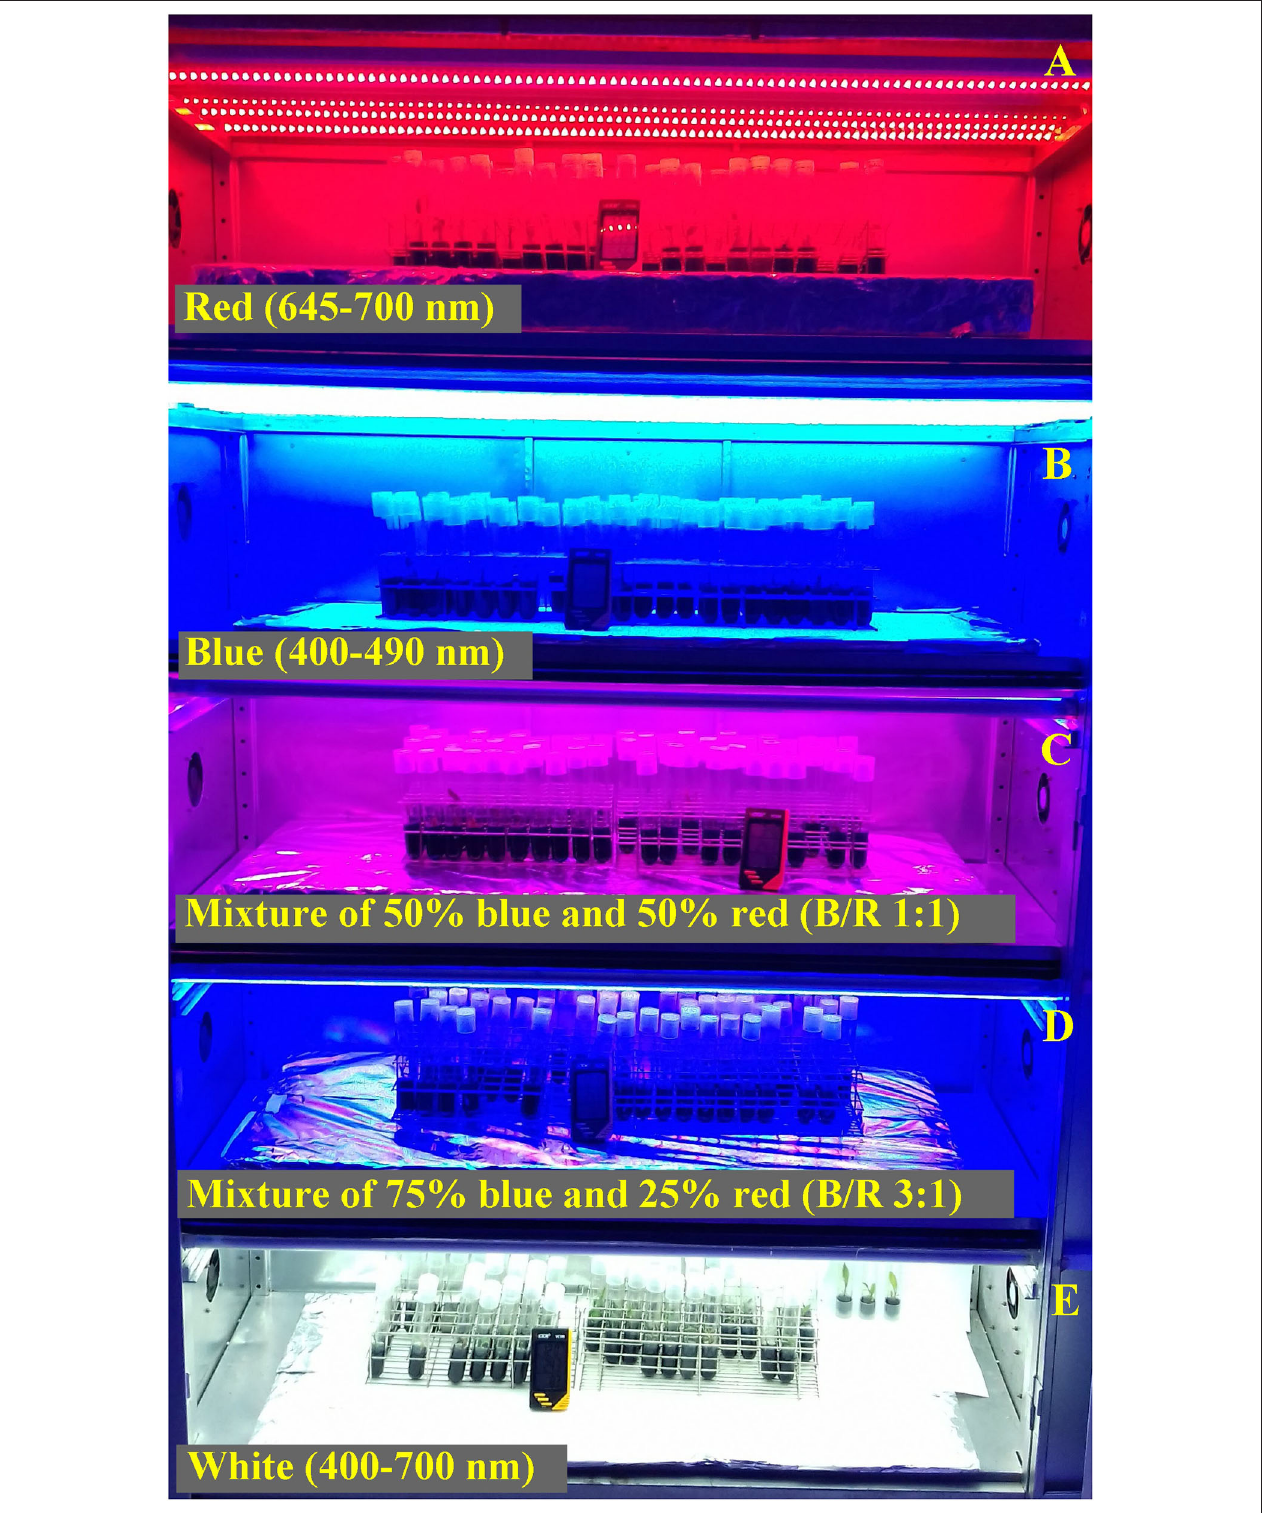
FIGURE 1 | Relative spectral distribution of LEDs: red (645–700nm) (A) ; blue (400–490nm) (B) ; mixture of 50% blue and 50% red (B/R 1:1) (C) ; mixture of 75% blue and 25% red (B/R 3:1) (D) , and white (400–700nm) (E) used in the in vitro culture of Brosimum gaudichaudii .